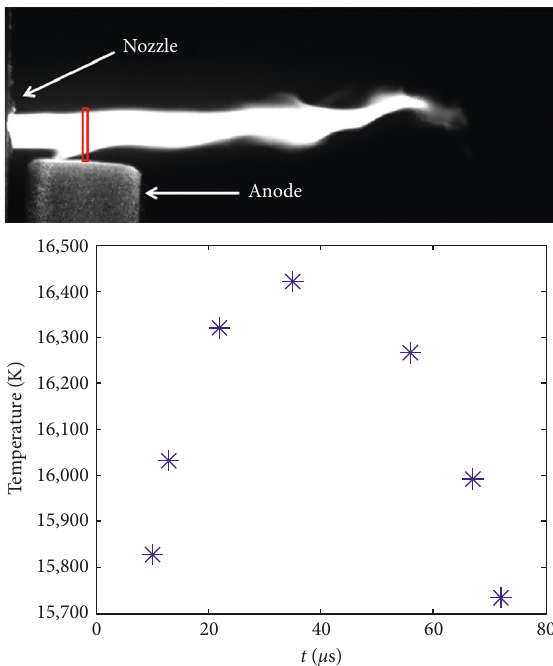
Figure 7: Temporal evolution of temperature during one period of restrike mode (measured in position 2 as shown by the red rect- angle in high-speed camera image above the graph).